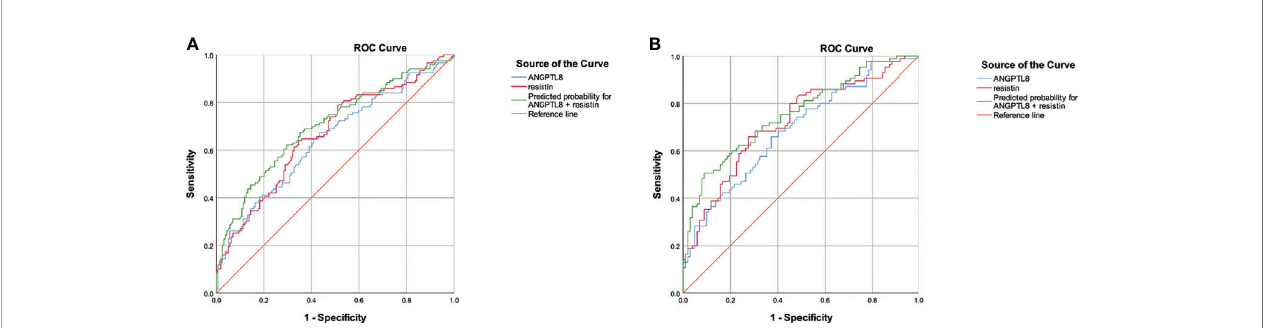
FIGURE 4 | ROC curves for the diagnostic accuracy of the ANTPTL8 and resistin for DN. (A) , ROC curves of total population. (B) , ROC curves in the non-NAFLD